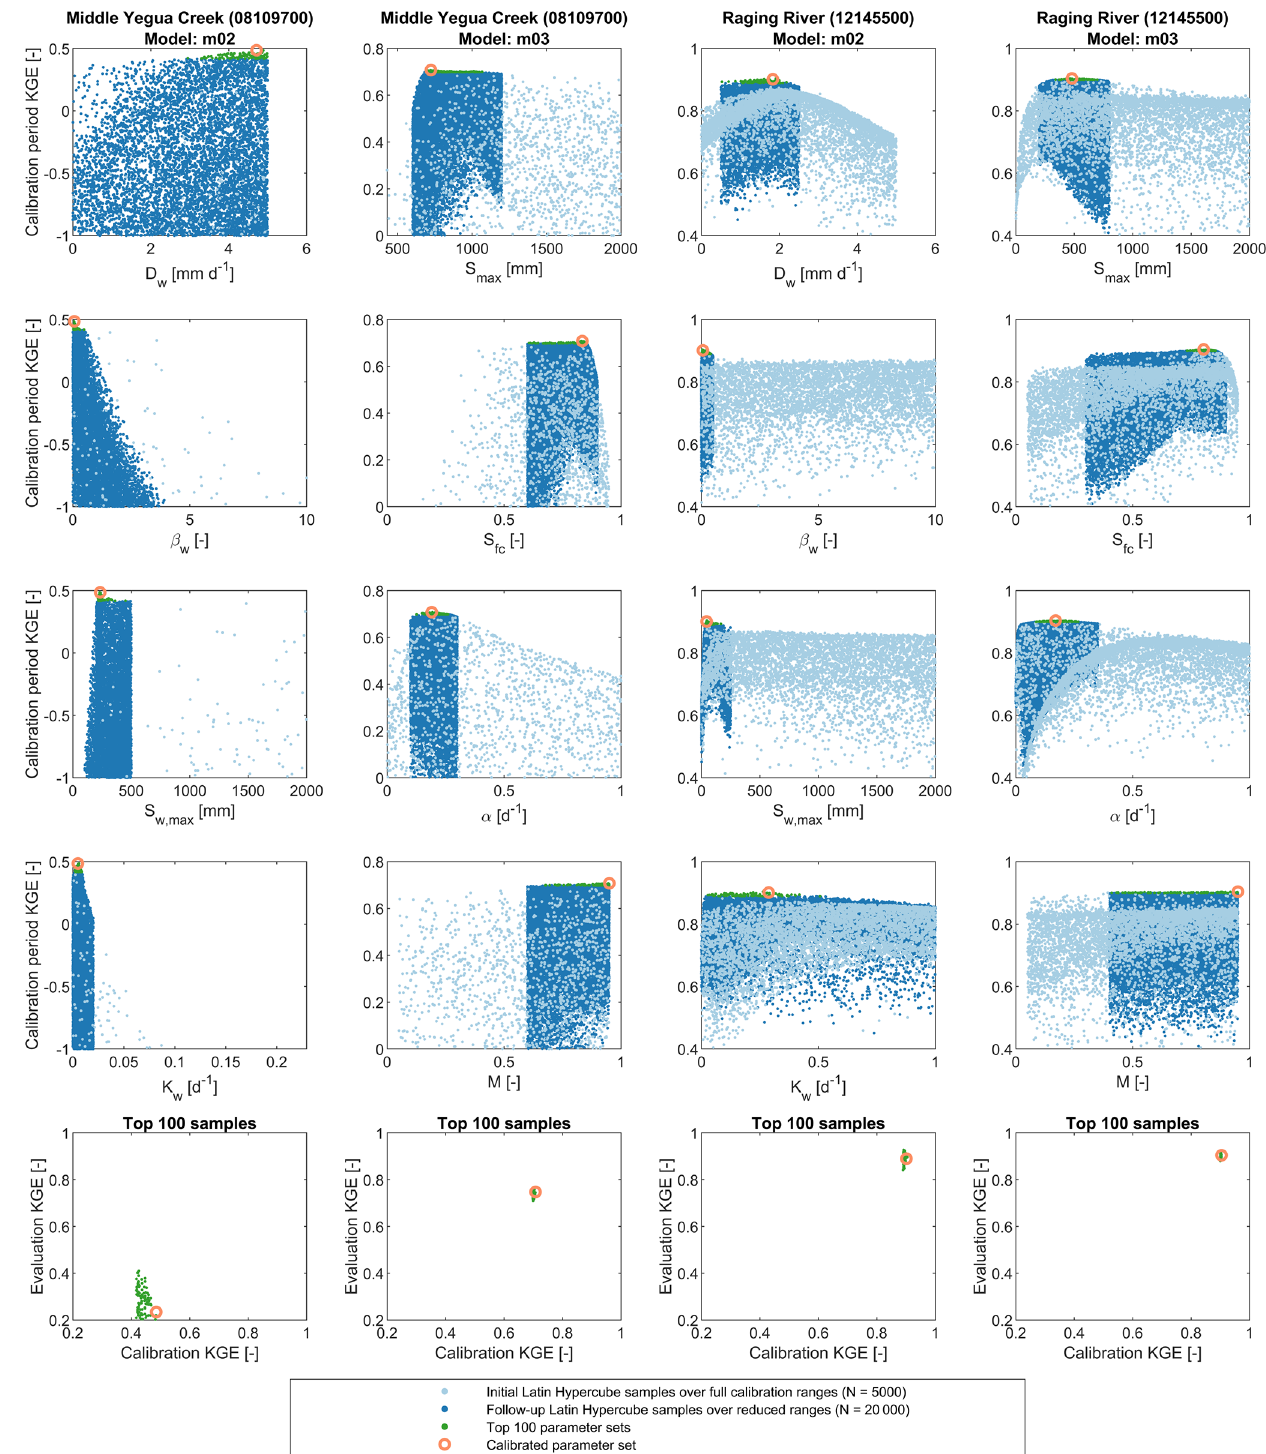
Figure 3. Top four rows: Latin hypercube parameter samples for both models and catchments, and associated KGE scores for the calibration period. Initial sampling (light blue) covered the full parameter ranges as used during model calibration to identify regions of interest for more thorough sampling (dark blue). See Fig. S4 for a version of this figure with wider limits on the y axes. Bottom row: comparison of calibration and evaluation KGE scores of the top 100 samples (defined as highest KGE scores for the calibration period) and calibrated parameter sets.